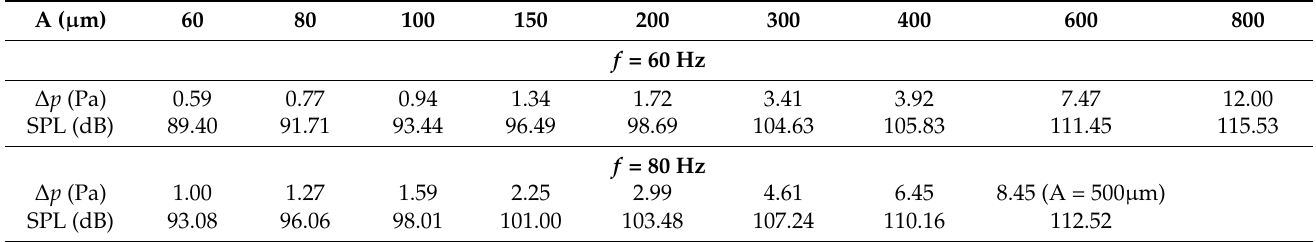
Table 1. SPL under different sound frequency values for particles of different